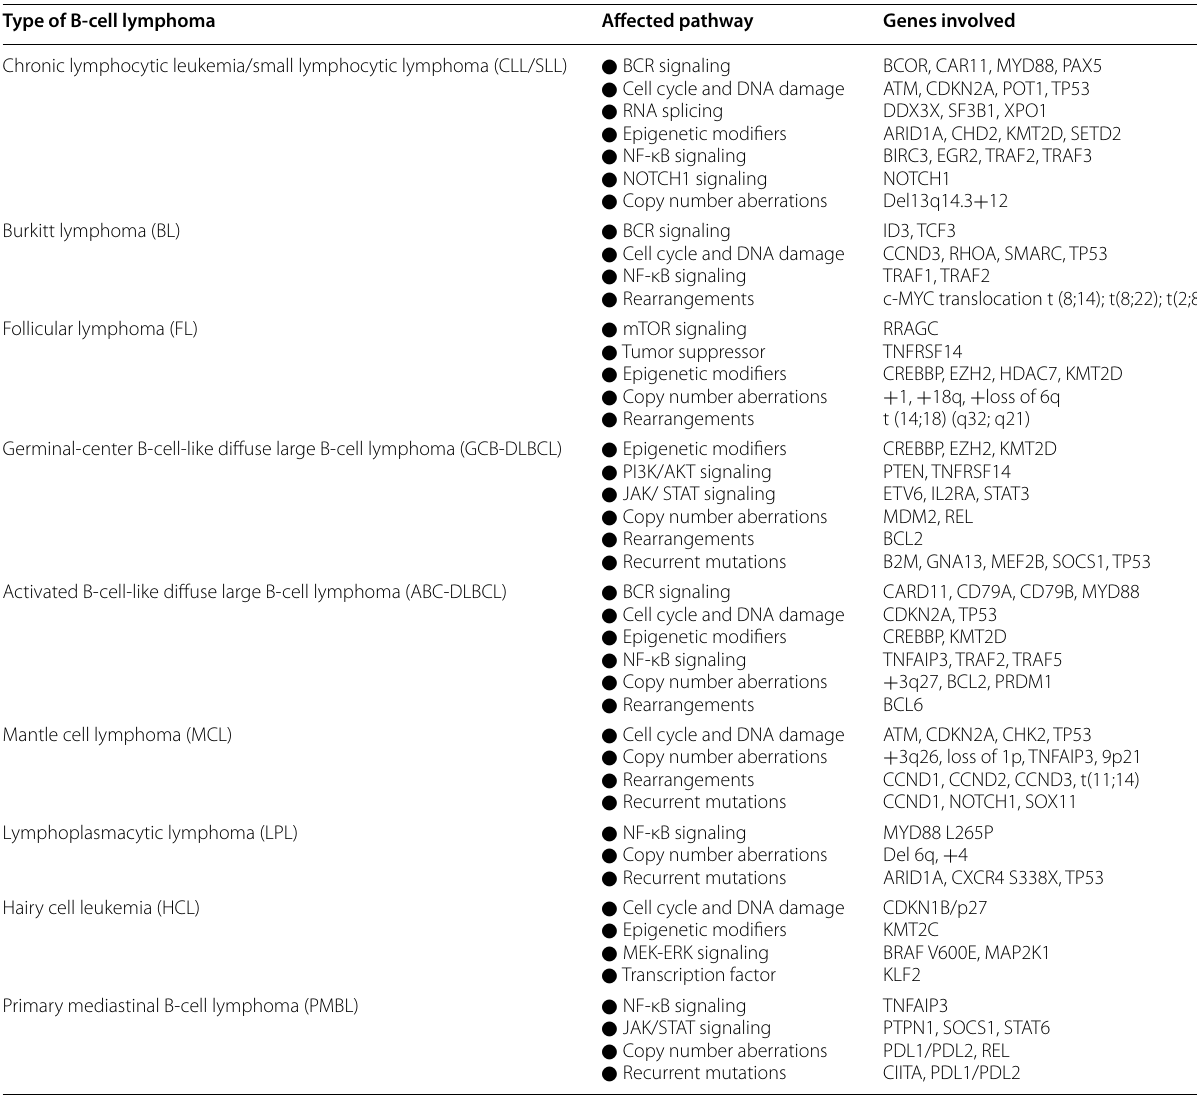
Table 1 Genetic aberrancies associated with major B-NHLs Type of B-cell lymphoma Affected pathway Genes involved Chronic lymphocytic leukemia/small lymphocytic lymphoma (CLL/SLL) ● BCR signaling ● Cell cycle and DNA damage